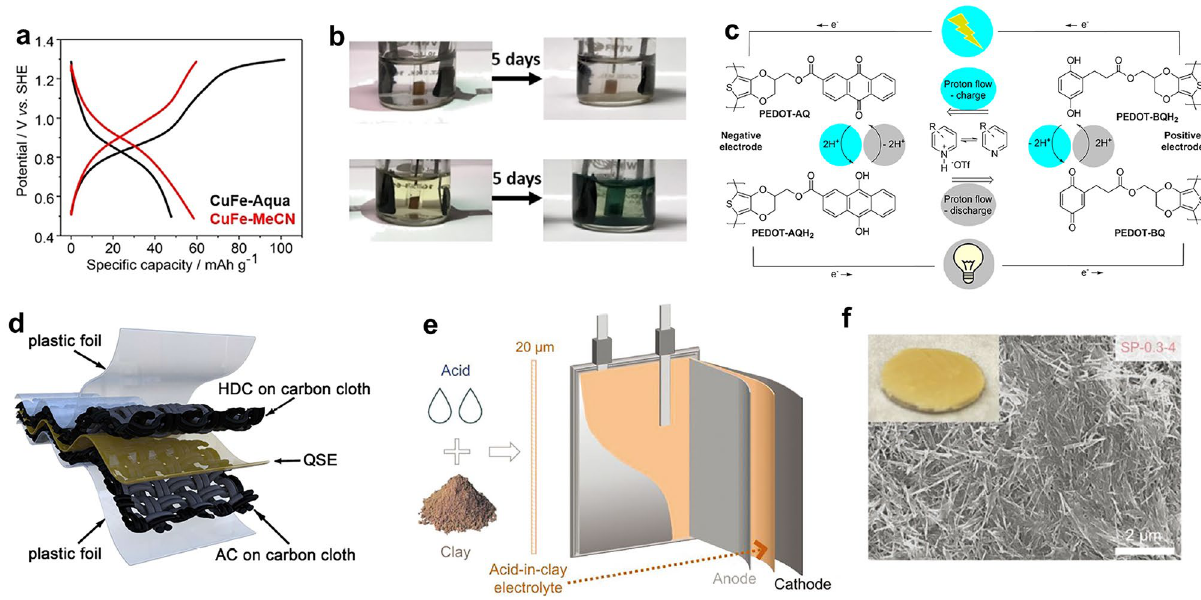
Fig. 7 a Galvanostatic charge/discharge profiles of the first cycle of Cu[Fe(CN) 6 ] 0.63 · □ 0.37 ·3.4H 2 O in aqueous and non-aqueous electrolytes. b Digital images of beaker cells of Mn[Fe(CN) 6 ] 0.63 · □ 0.37 ·3.4H 2 O before and after cycling at 10 mAg −1 for five days in aqueous and non-aqueous electrolytes [41]. Copyright 2020, Wiley–VCH. c The schematic illustration of the all-organic poly(3,4-ethylenedioxythiophene)-benzonquinone (PEDOT-BQ)//poly(3,4-ethylenedioxythiophene)-anthraquinone proton battery [79]. Copyright 2017, American Chemical Society. d Schematic diagram of the metal-free quasi-solid flexible soft-packed battery [60]. Copyright 2022, Wiley–VCH. e Schematic diagram and f SEM image of acid-in-clay electrolytes. Inset of f : photograph by a camera [80]. Copyright 2022,